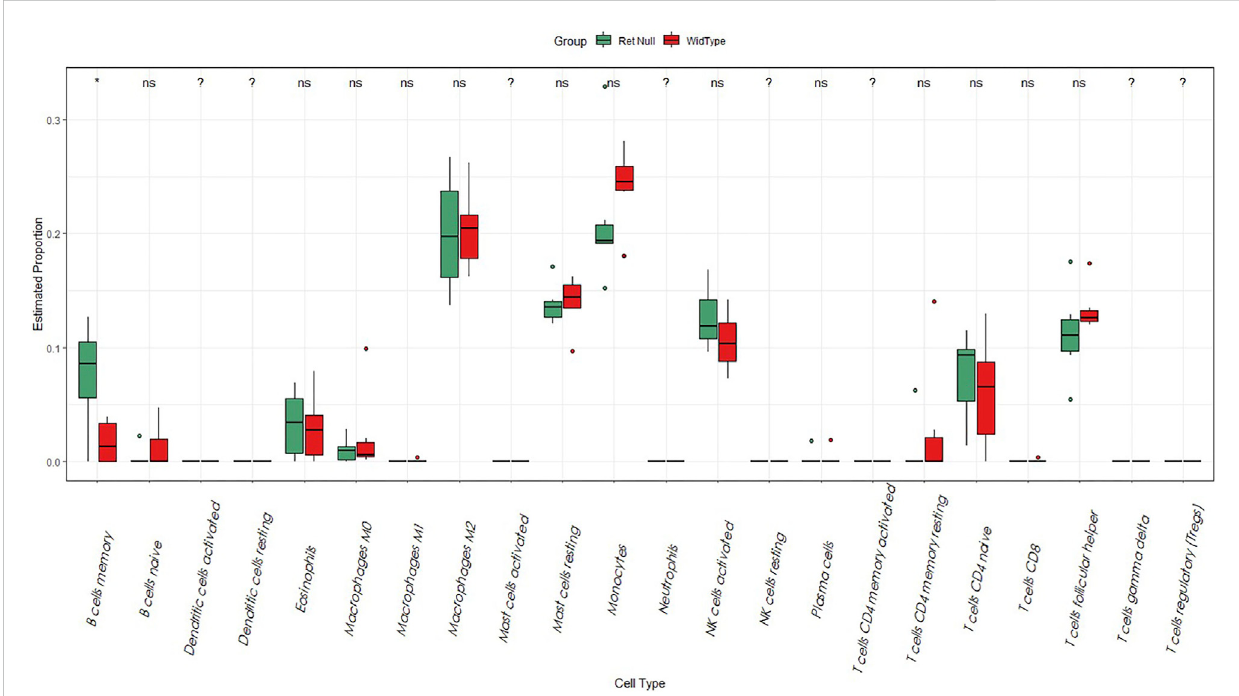
FIGURE 3 Box plot of the proportion of immune cells in Wide Type and RET Null mouse intestinal samples. The horizontal coordinate is the type of immune cellsandtheverticalcoordinateistheproportionofimmunecells.GreenrepresentstheproportionofimmunecellsinRETNullmouseintestinalsamples, red represents the proportion of immune cells in Wide Type, and p < 0.05 is marked as “ * ”